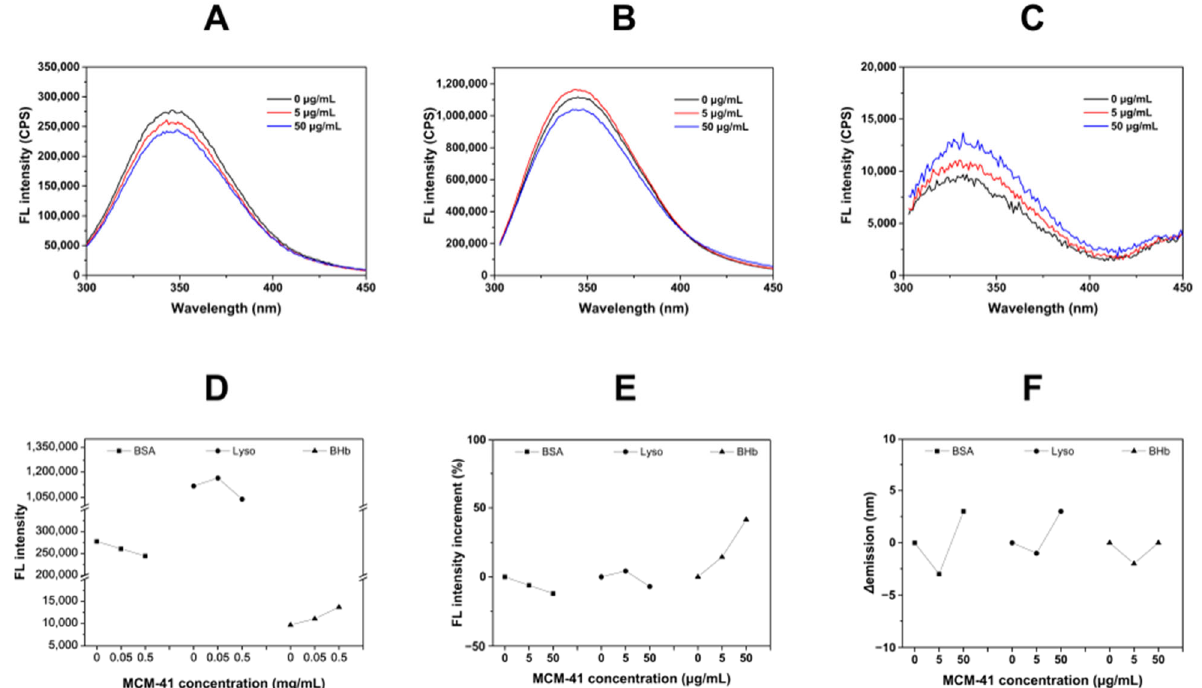
Figure 3. ( A – C ) Fluorescence spectra of MCM ‐ 41 incubated with BSA ( A ), Lyso ( B ) and BHb ( C ). ( D ) The fluorescence intensity increments of different proteins which were incubated with MCM ‐ 41. ( E ) The percentage of fluorescence intensity increment of different proteins incubated with MCM ‐ 41. ( F ) The Δ emission of different proteins incubated with MCM ‐ 41.